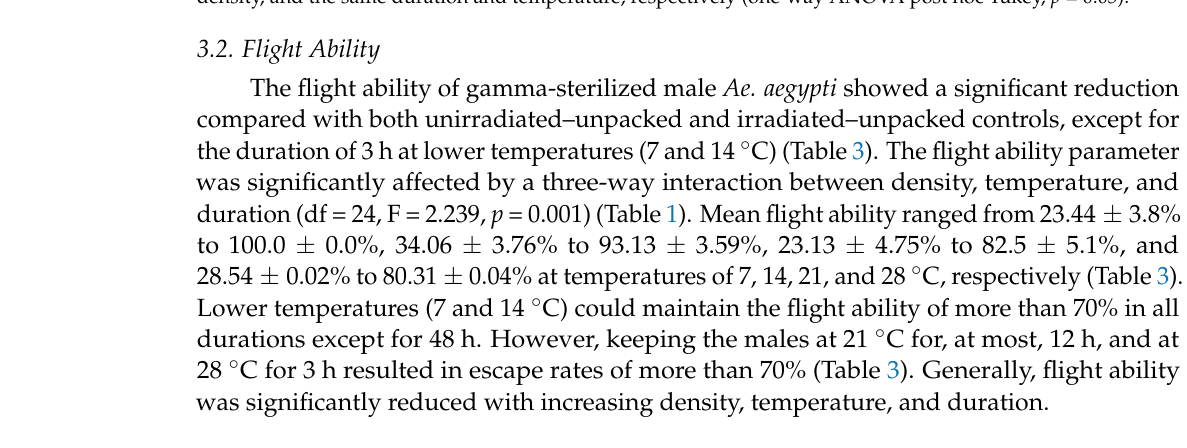
Table 3. Mean flight ability of gamma-sterilized male Ae. aegypti post-treatment by density, tempera- ture, and duration